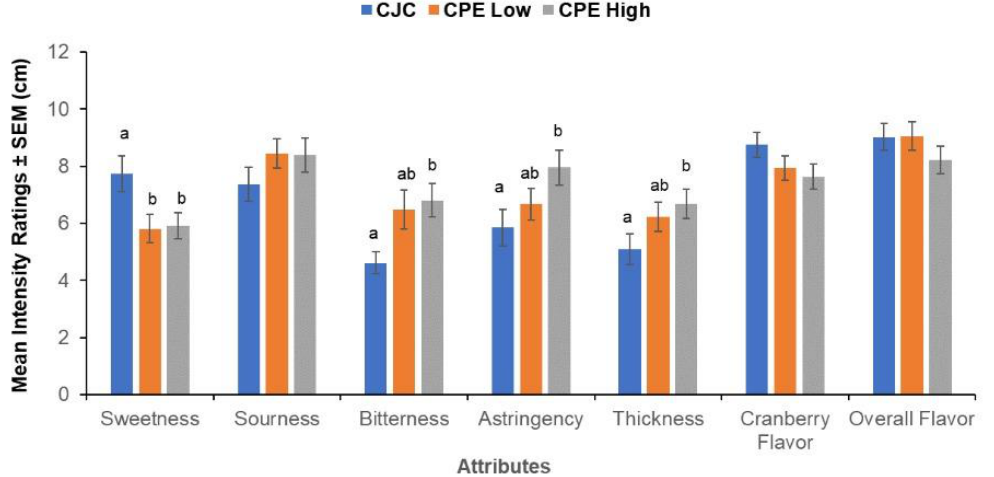
Figure 7. Evaluation of taste samples. Mean intensity ratings ± SEM (cm) for key flavor attributes present in cranberry juice cocktail (CJC) with 0 g/L CPE, 0.5 g/L CPE (Low), and 0.8 g/L CPE (High) of added cranberry polyphenol extract. Letters (a, b) indicate significant differences as a function of concentration (within-subjects) at p < 0.05 in a repeated measures MANOVA ( n = 20).